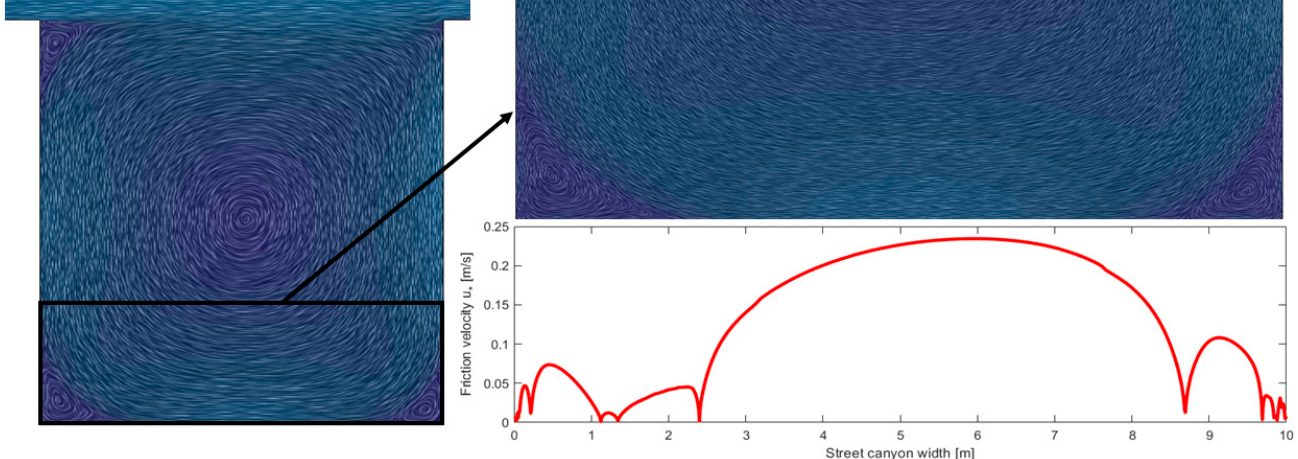
Figure 3. Detailed view of the bottom of the street canyon (H/W = 1, u ref = 12.5 m/s, 6th canyon), where the vortexes and the corresponding friction velocity are visible.